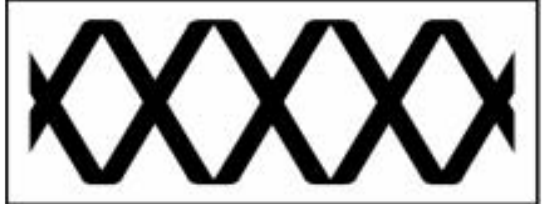
Fig. 6. Optimized panel’s F.E.